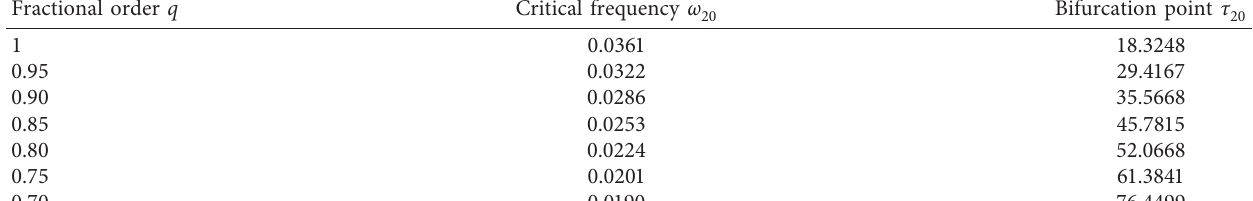
, and τ of model (4). 20 20